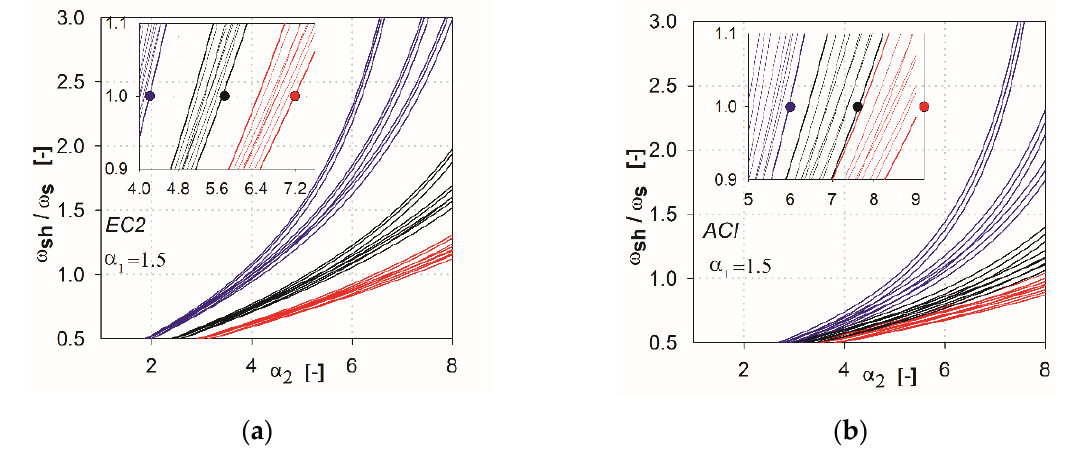
Figure 9. Graphs obtained for the parameter 𝛼 1 = 1.5 : ( a ) for the EC2 standard; ( b ) for the ACI code.